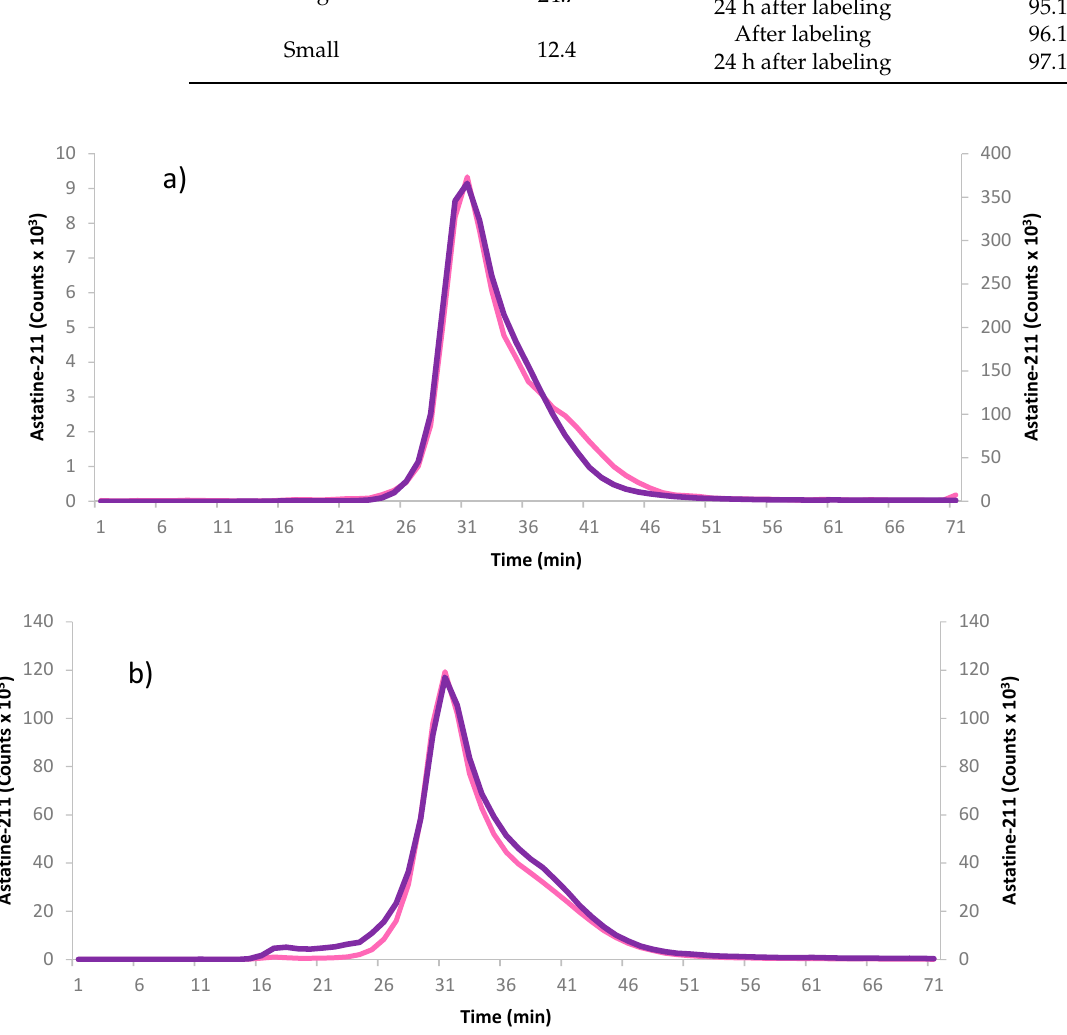
Figure 3. Fast protein liquid chromatography (FPLC) chromatograms of astatinated effector molecules of two different sizes ( a ) top panel 10 kDa, ( b ) bottom panel 22.5 kDa, comparing fraction collected radioactivity peaks directly after radiolabeling (pink) and 24 h after radiolabeling (purple).